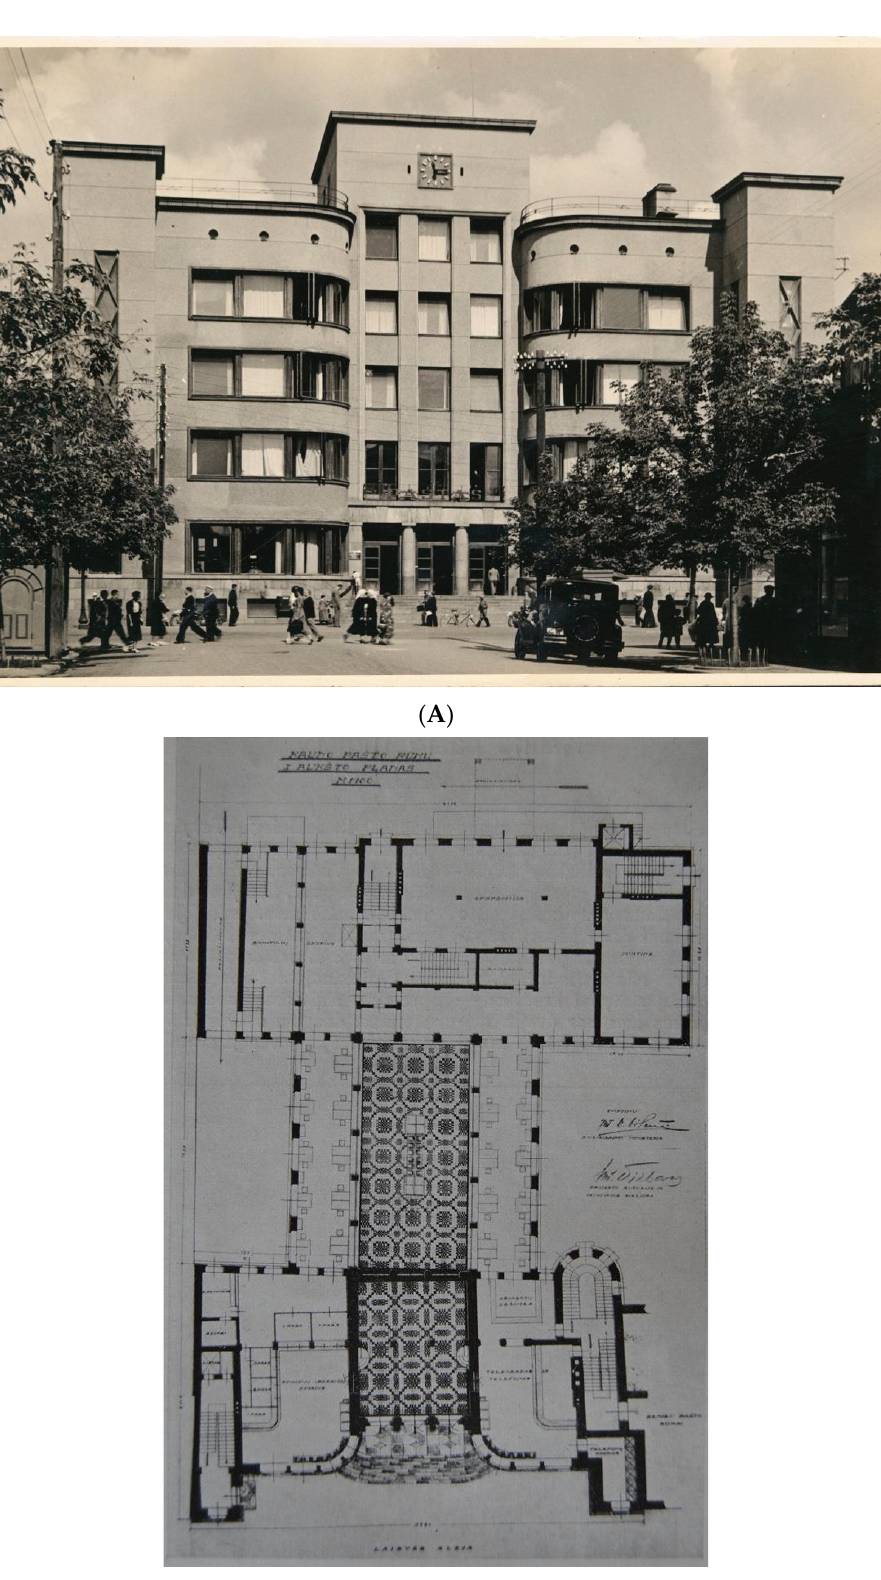
Figure 5. ( A ) National Modernism featured a combination of modernism with the vernacular, as in the concrete window details of the Central Post Office that resembled the vernacular wood carvings of architect Feliksas Vizbaras. Photo: 1930s, source: Lithuanian Central State Archives. ( B ) The traditional village weaving pattern in the ornamental flooring in the lobby and transaction hall of the Central Post Office interior, 1930. Source: Technika ir ūkis , 1933, no. 5.